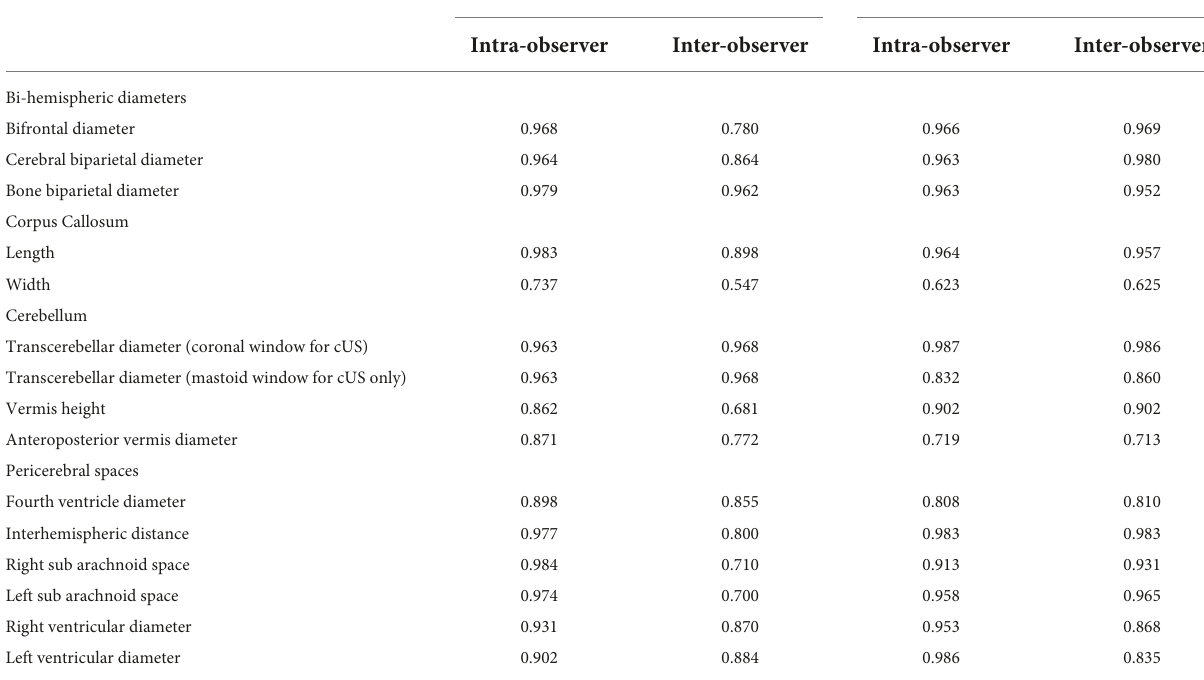
TABLE 4 MRI and cUS intra- and inter-observer